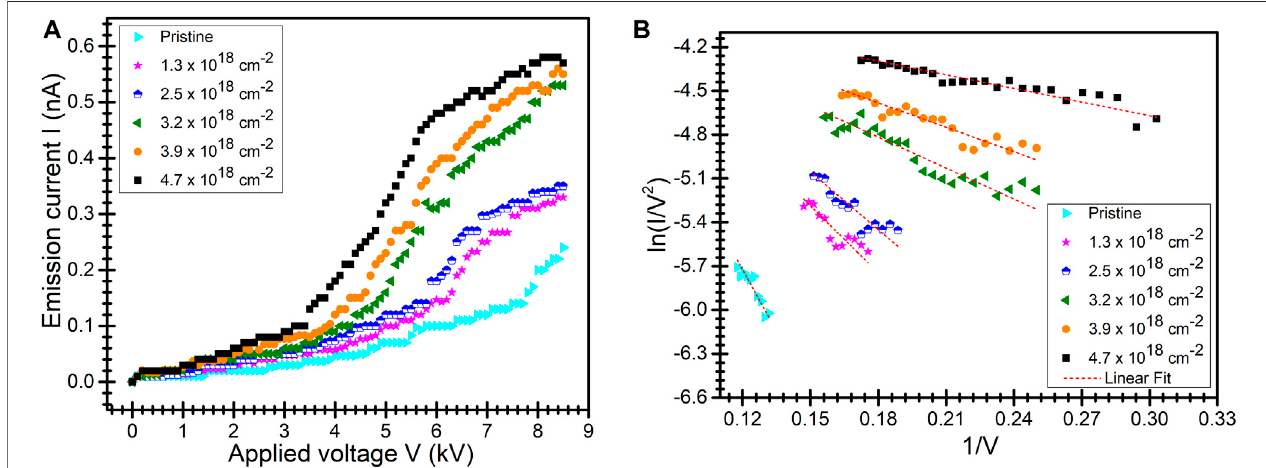
TABLE 1 | A comparison of implanted argon concentration, work function variation with microcones distribution for pristine and irradiated samples. Fluence ( × 10 18 cm − 2 ) Implanted argon concentration